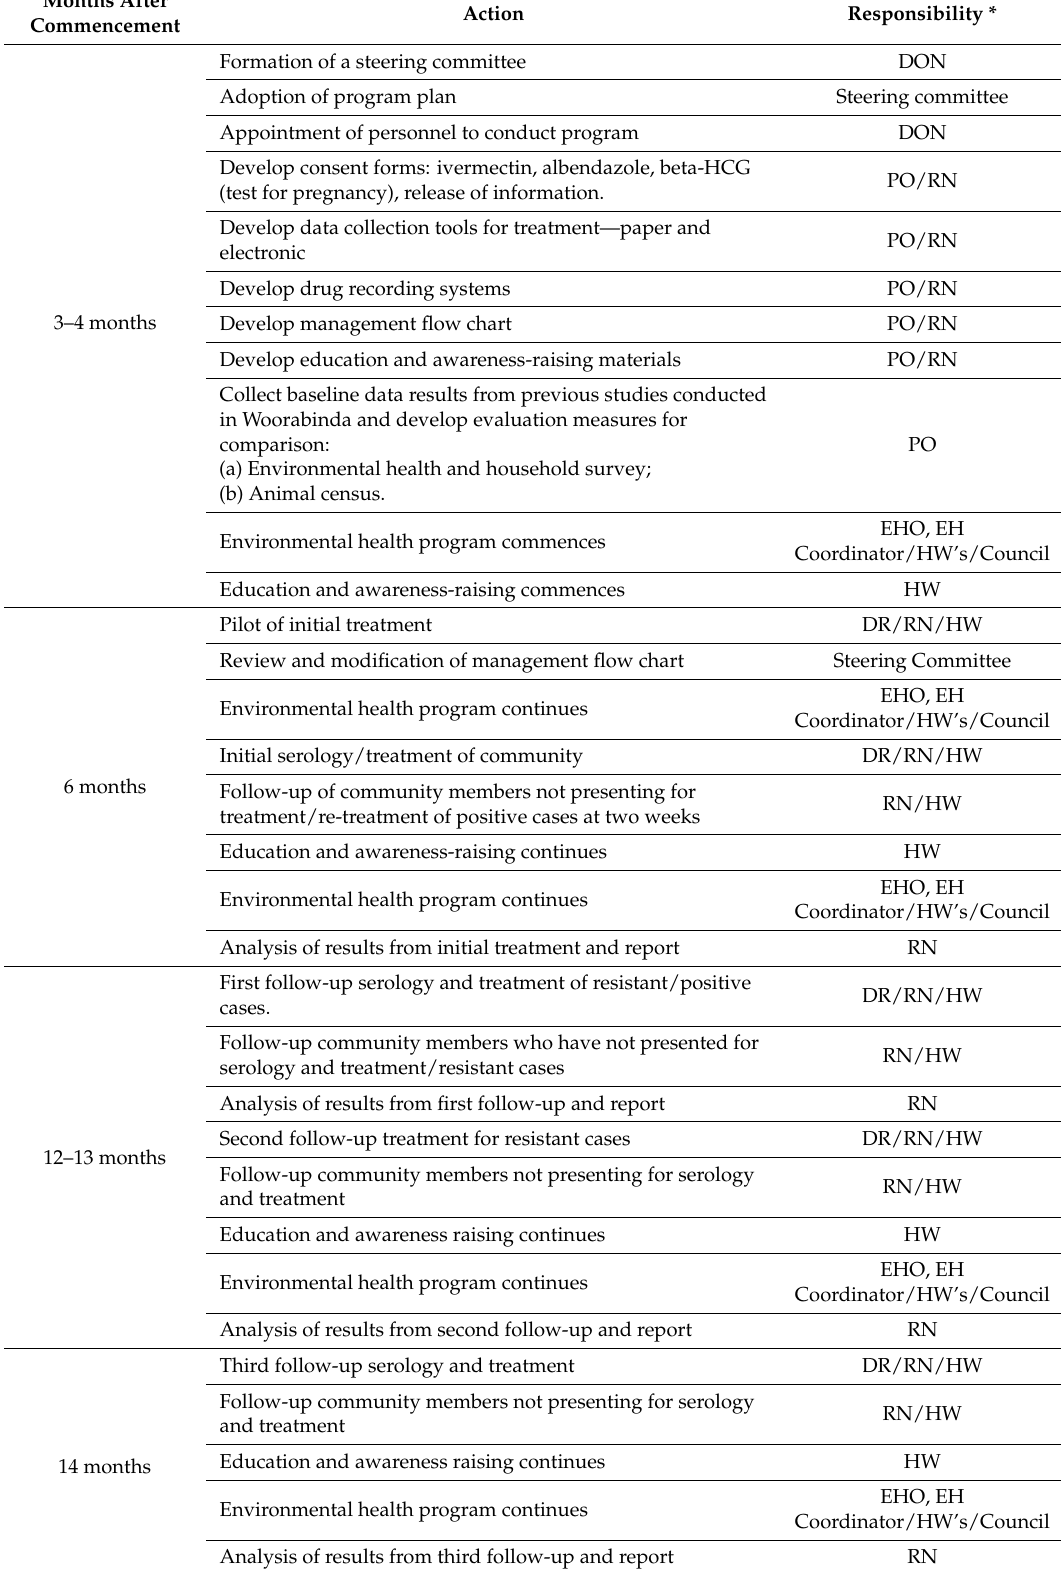
Table 1. Woorabinda S. stercoralis Control Program Work